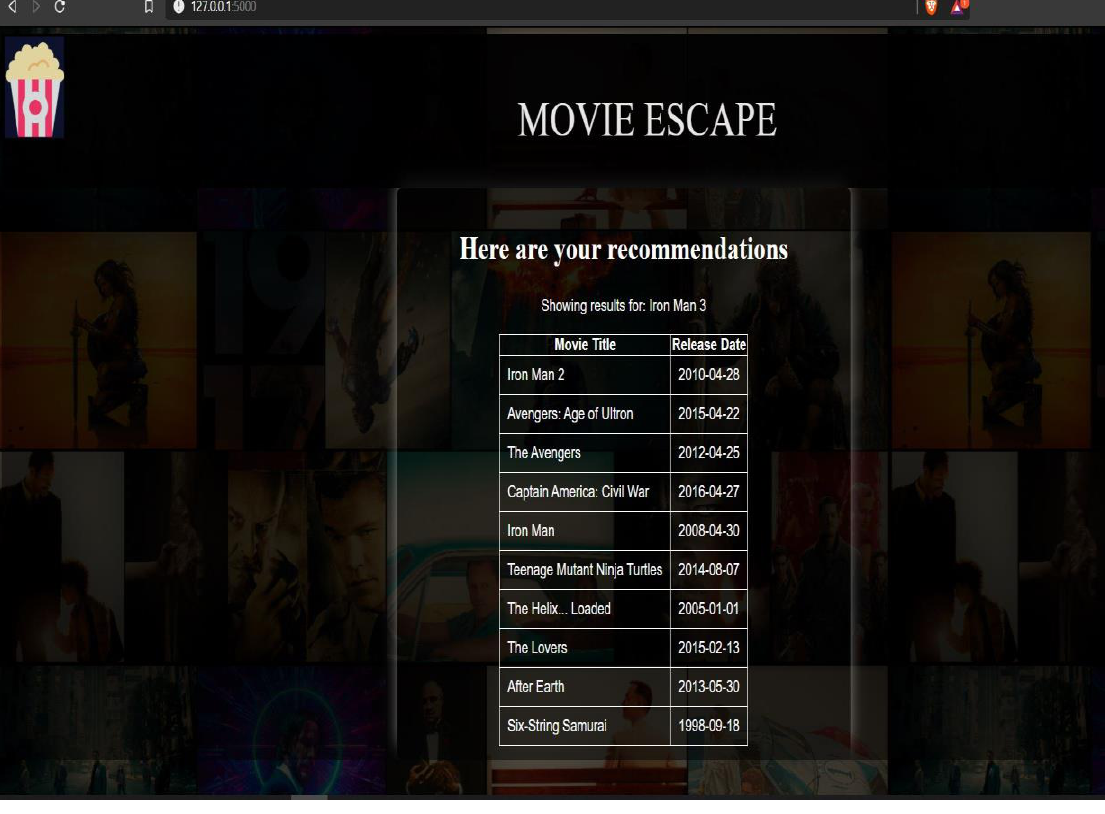
Figure 3. Search result suggestions based on the search input “Iron Man